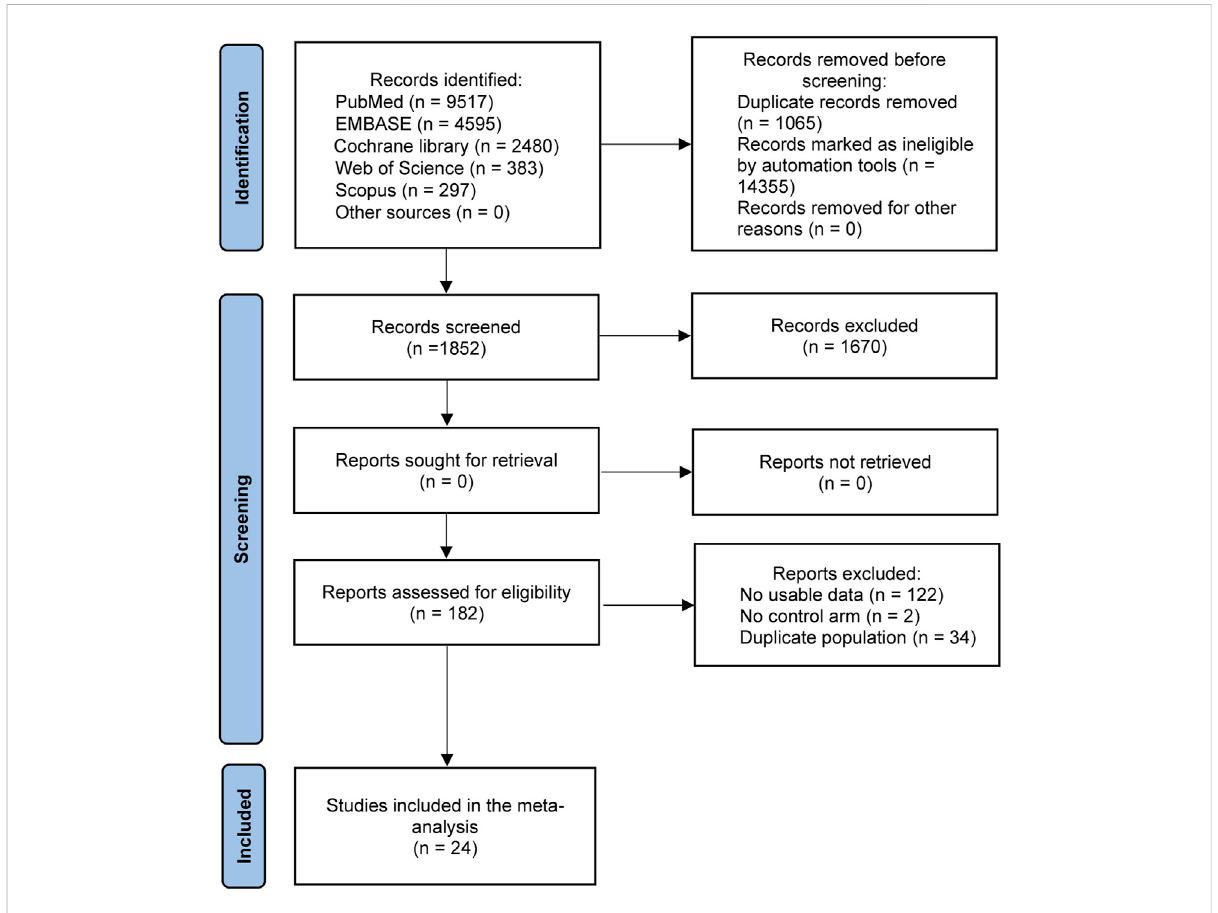
FIGURE 1 Flow chart diagram of study